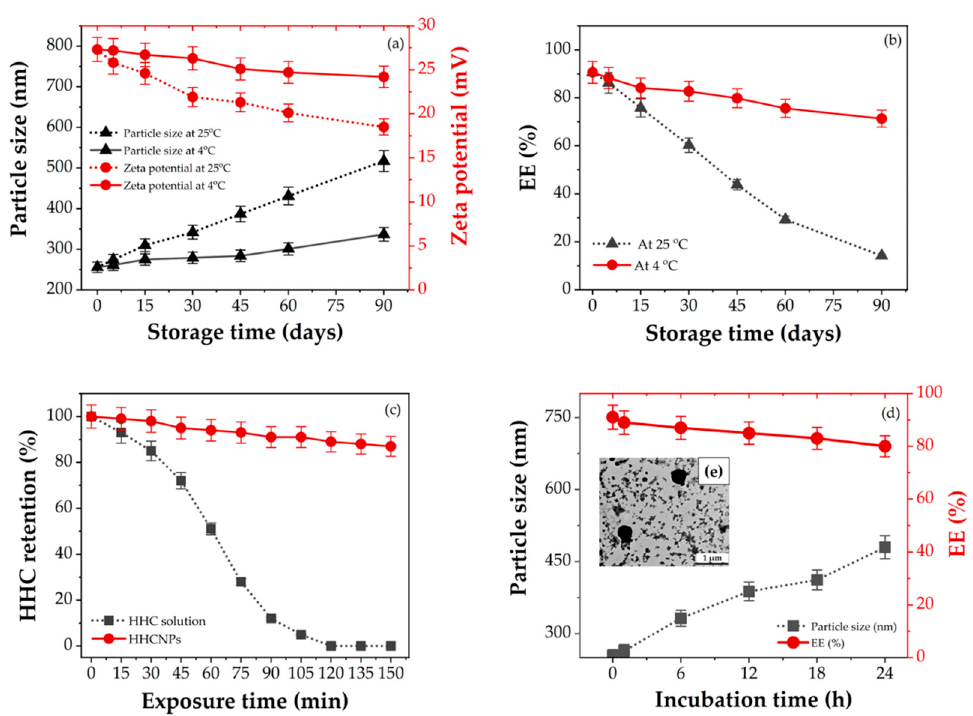
Figure 4. The storage stability of HHC-CS-NPs is expressed in changes of ( a ) particle size and zeta potential and ( b ) EE at 4 ◦ C and 25 ◦ C for 90 days ( n = 3); ( c ) percentages of retention HHC in HHC-CS-NPs and HHC solution upon exposure to UV light radiation ( n = 3); ( d ) protein stability expressed in the change in particle size and EE of HHC-CS-NPs after incubation with BSA at 37 ◦ C; ( e ) TEM analysis of HHC ‐ CS ‐ NPs after 24 h incubation with BSA (at 10,000× magnification).